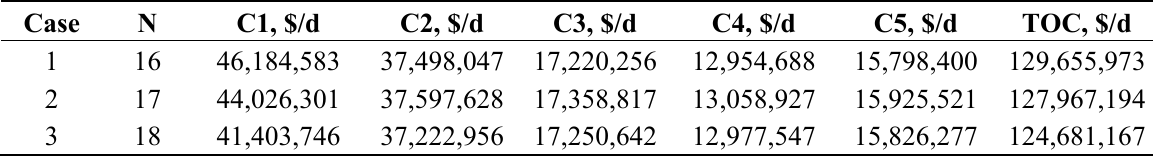
Table 2 . Summary of optimisation